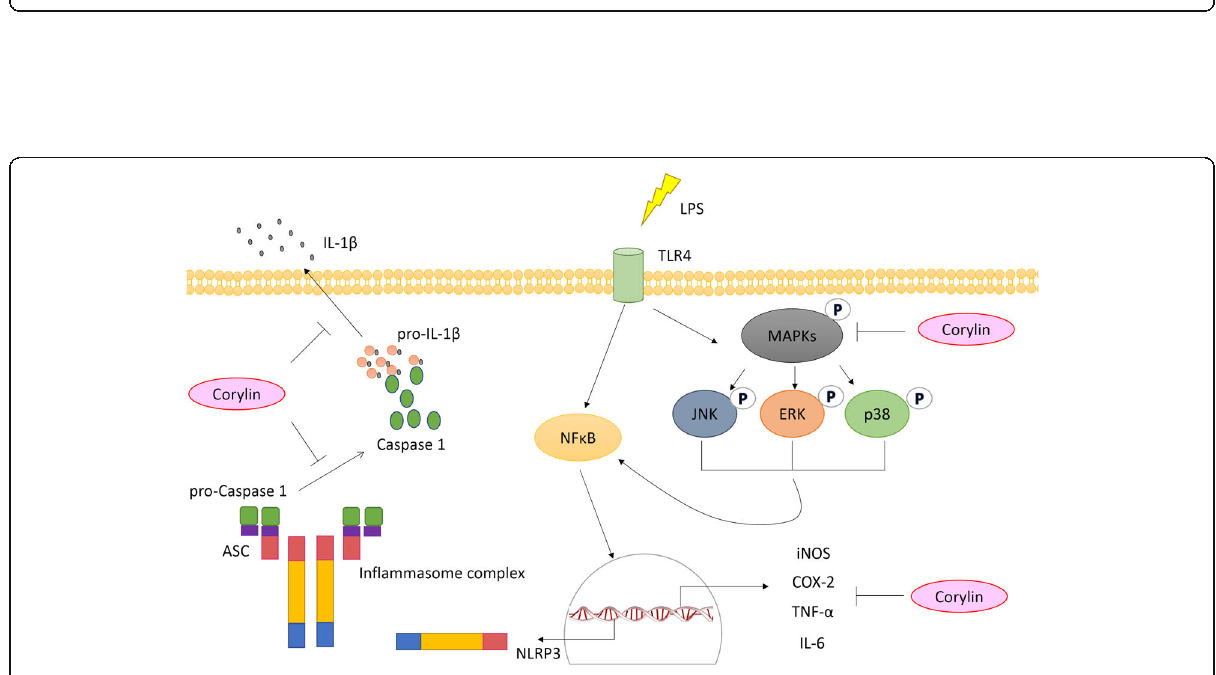
Fig. 5 Effects of corylin on the expression of NLRP3 and colocalization of NLRP3 with caspase-1 (green) in LPS-activated BV2 cells. Cells were incubated with various doses of corylin for 1 h, and then treated with LPS (1 μ g/mL) for 24 h. a Representative fluorescent microscopy images showing the expression of NLRP3 (red) in LPS-activated BV2 cells. The nuclei were stained with Hoechst 33,342 (blue). b Representative fluorescent microscopy images showing the colocalization of NLRP3 (red) with caspase-1 (green) in LPS-activated BV2 cells. The nuclei were stained with Hoechst 33,342 (blue). Scale bars, 10 μ